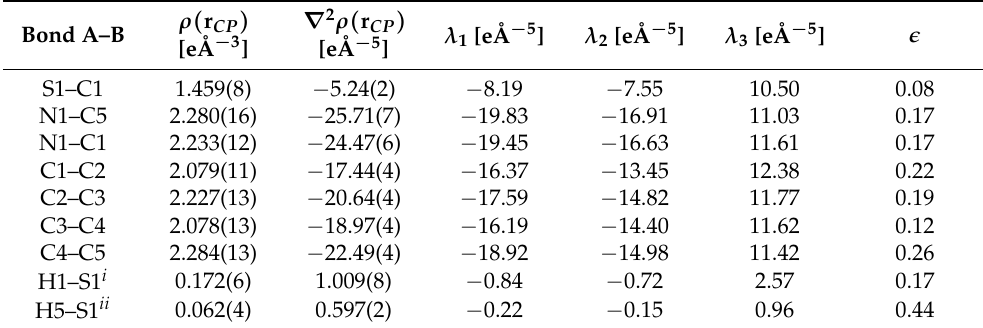
Table 5. Topological analysis of the bond critical points r CP in (I) . ρ is the electron density, λ 1 , λ 2 and λ 3 are the eigenvalues of the Hessian matrix. (cid:101) is the bond ellipticity. Symmetry